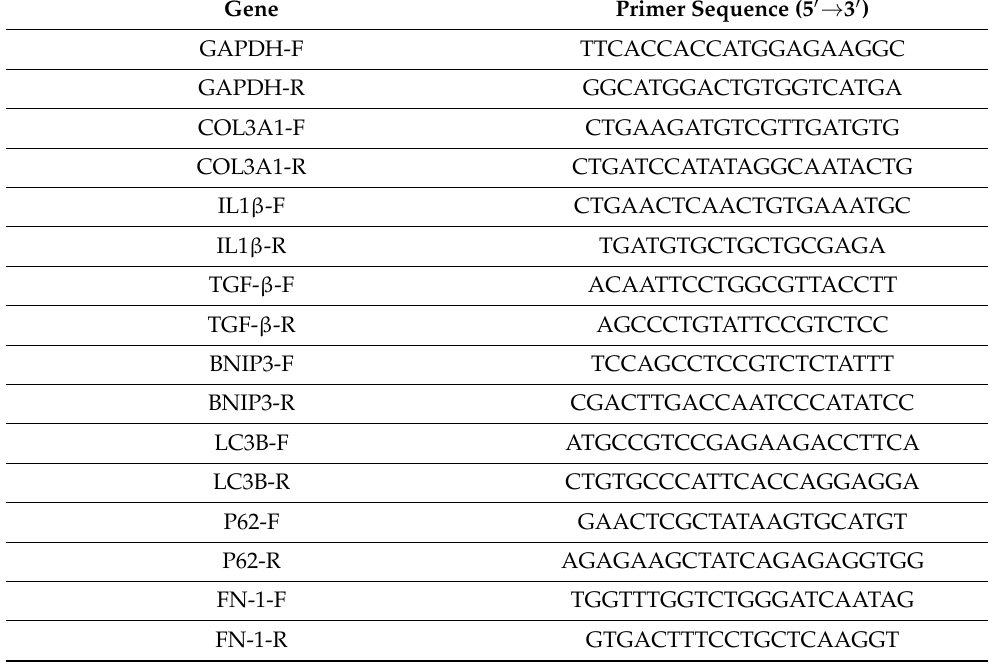
Table 1. The gene-specific primers used in this study. Gene Primer Sequence (5 (cid:48) → 3 (cid:48)